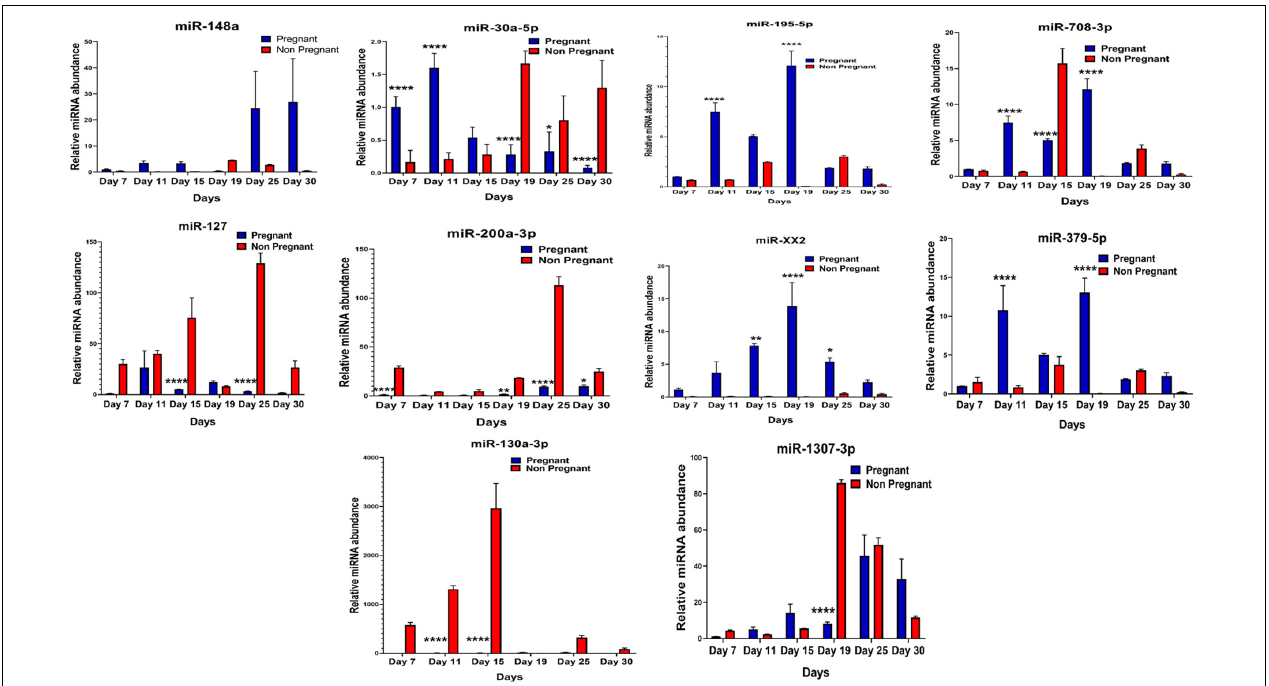
FIGURE 4 | Graphical representation of the abundance of shortlisted miRNAs in the blood plasma of pregnant and non-pregnant animals. Here, X axis represent the relative miRNA abundance and Y axis represent the Days. Blue and red columns represent pregnant and non-pregnant animals. * p < 0.05; ** p < 0.01; and **** p < 0.0001.